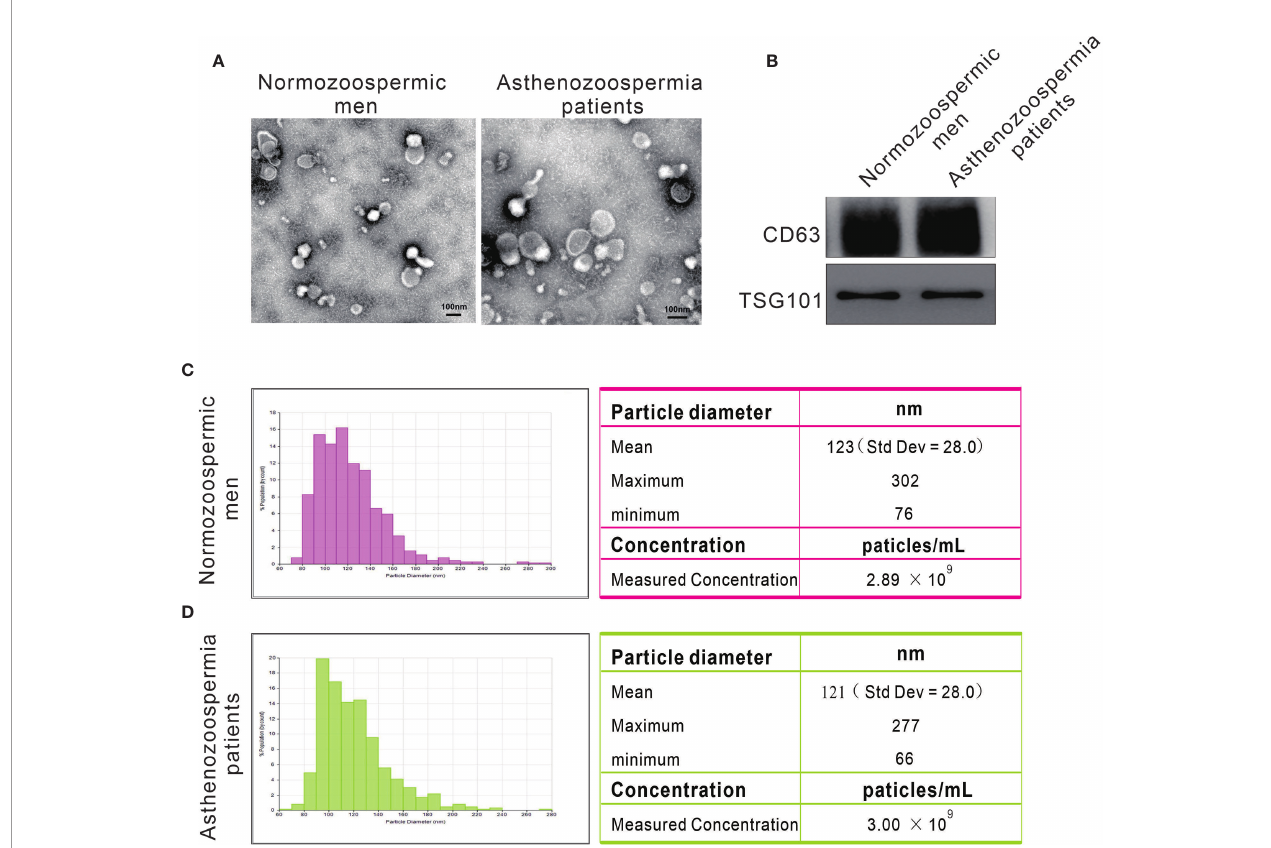
FIGURE 1 | Particles isolated from seminal plasma exhibit the characteristic features of exosomes. (A) Representative transmission electron micrographs of exosomes. (B) Western blots on exosomes using antibodies against the common exosomal markers CD63 and TSG101. (C, D) Representative particle size distribution pro fi les from seminal plasma of normozoospermic men and asthenozoospermia